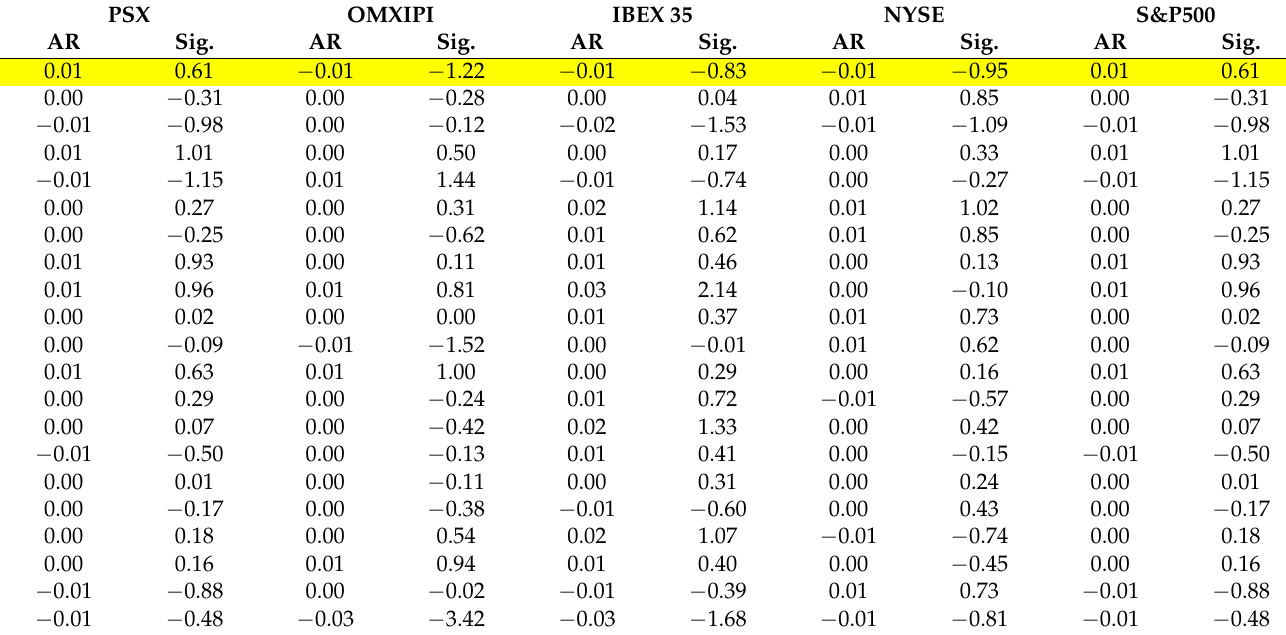
Table A2. Abnormal returns of the (0, +20) event window (News of Panama leaks).